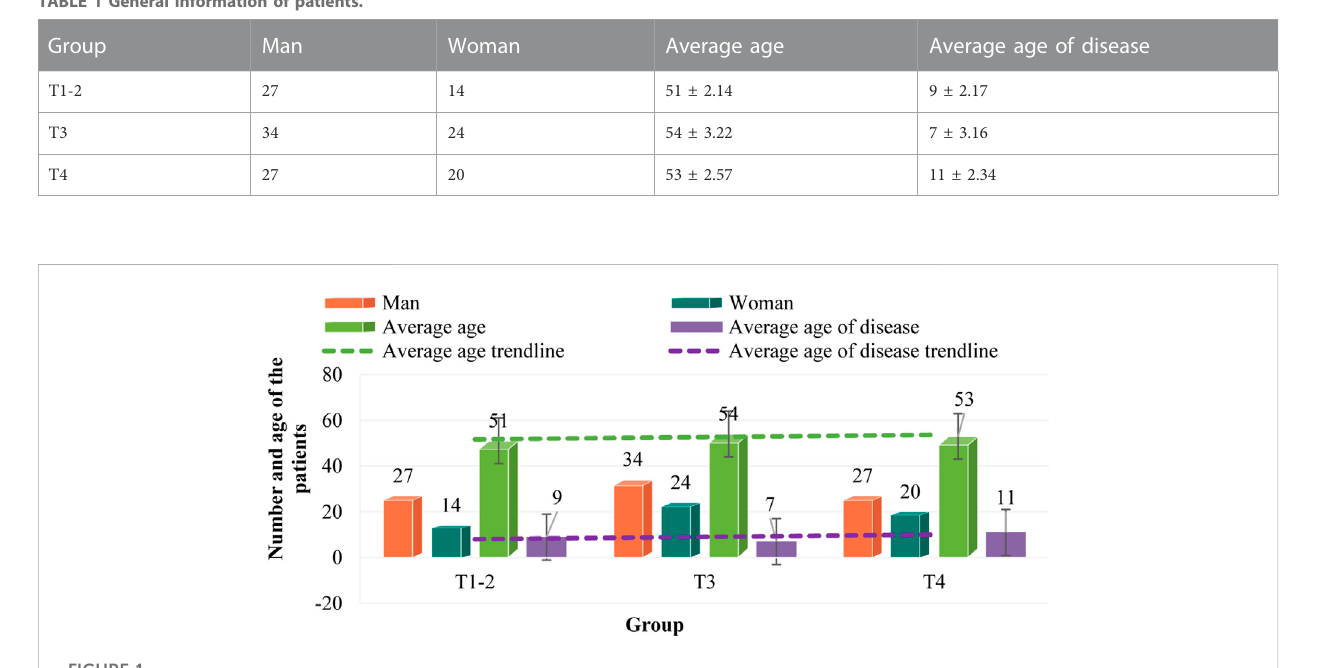
FIGURE 1 Comparison of general patient